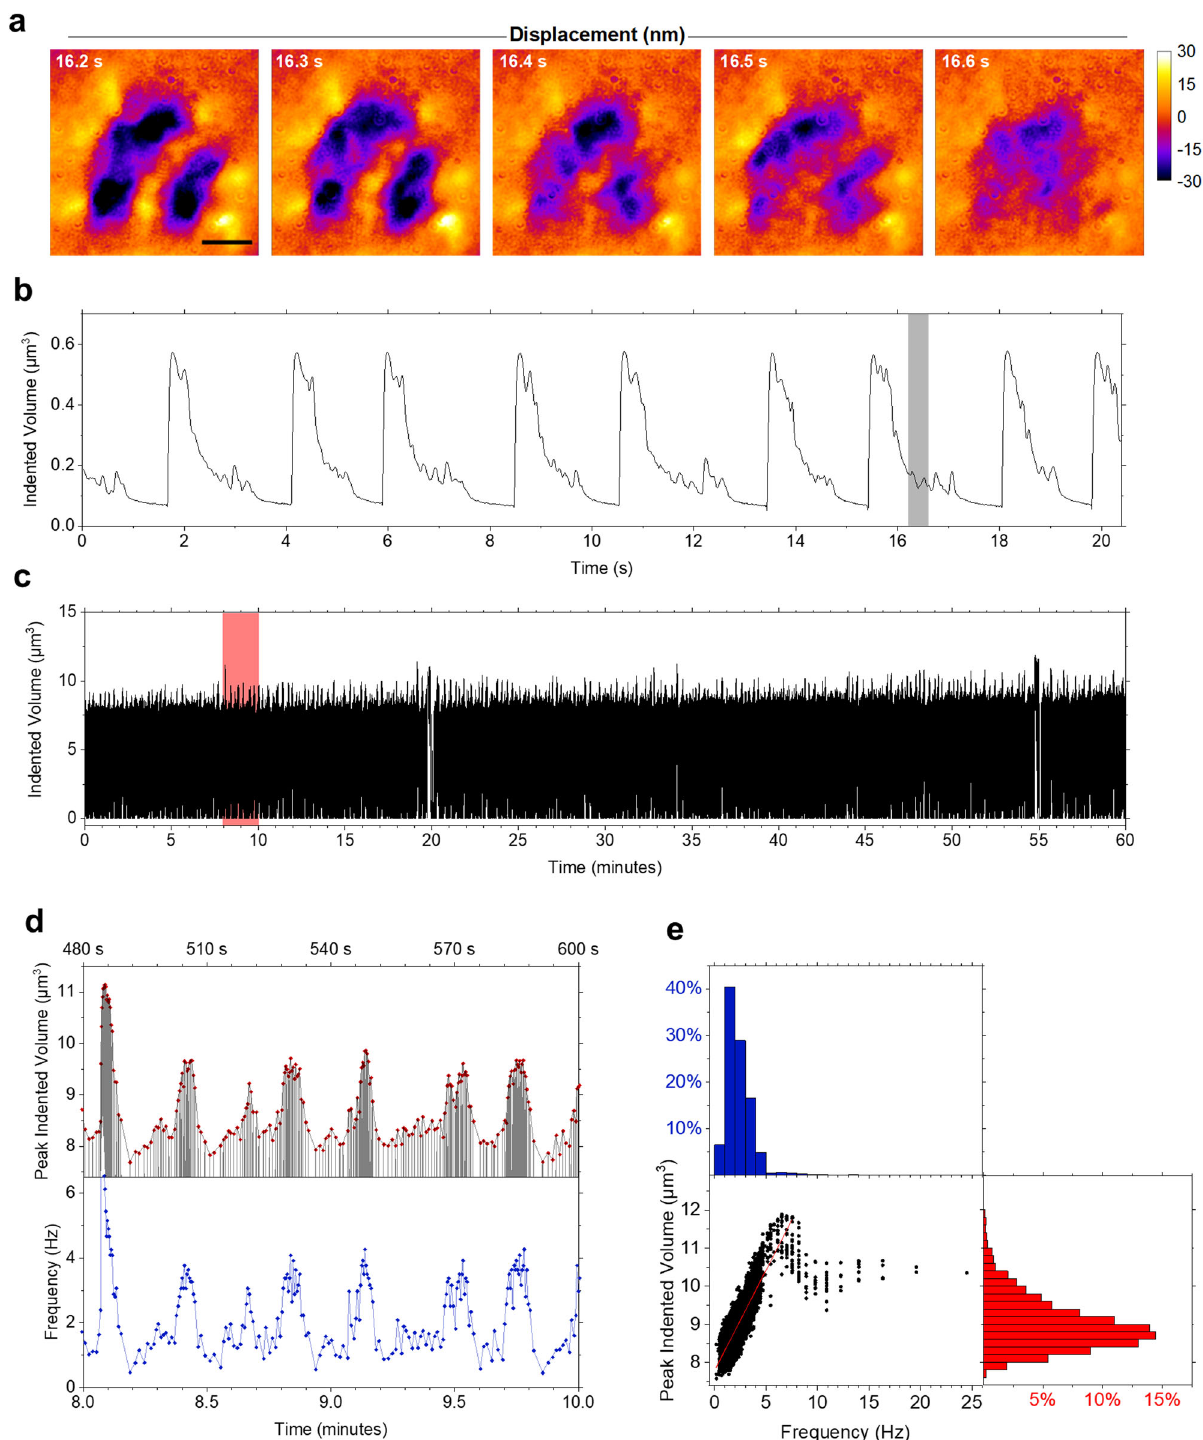
Fig. 5 WARP measurements across different scales. a Section from a 100 fps WARP measurement of cardiomyocytes with characteristic micro- contractions during the resting phase between the main contractions. Spatial Fourier- fi ltering was applied to fi lter out the broad, contraction-induced deformation patterns. b Temporal evolution of the indented volume for cells in a over nine contraction cycles. The section marked by the grey box corresponds to the period shown in a . c Evolution of indented volume in the central region of a cell taken from a 1 h long-term measurement. d Indented volume (grey line), and for each contraction cycle the peak indented volume (red dots) and contraction frequency (blue dots). Shown is the time interval marked by the red box in c . e Correlation analysis of peak indented volume and contraction frequency (centre panel, black dots). Red line indicates a linear fi t to the data below 8 Hz ( R 2 = 0.76). Histograms of peak indented volume (right panel, red bars) and contraction frequency (top panel, blue bars). Scale bar, 20 μ m. Images are representative of two independent observations from one